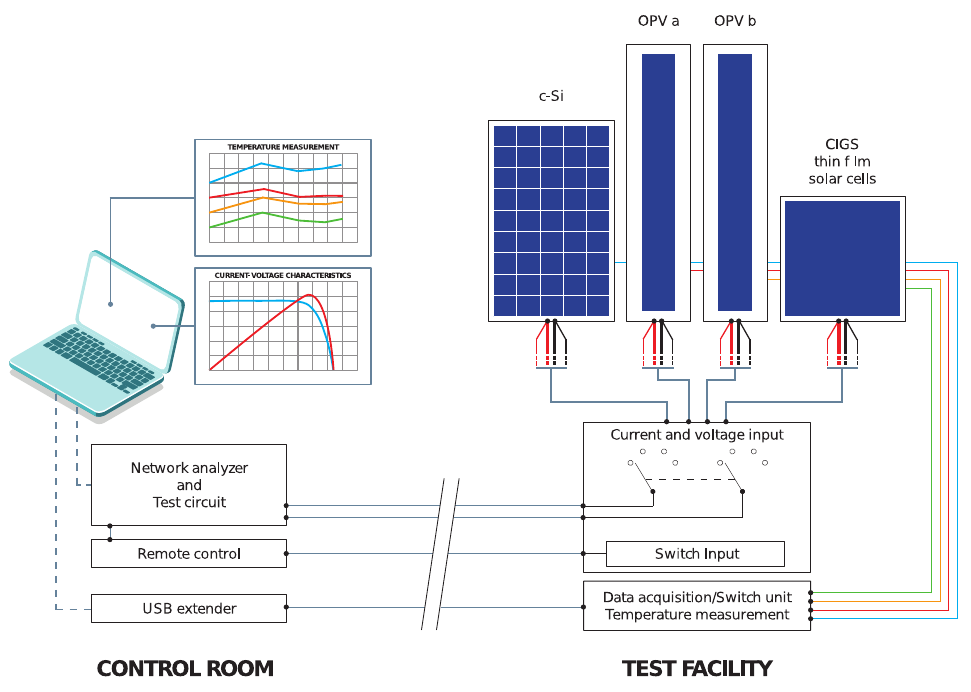
Figure 1. Diagram of the data acquisition system.